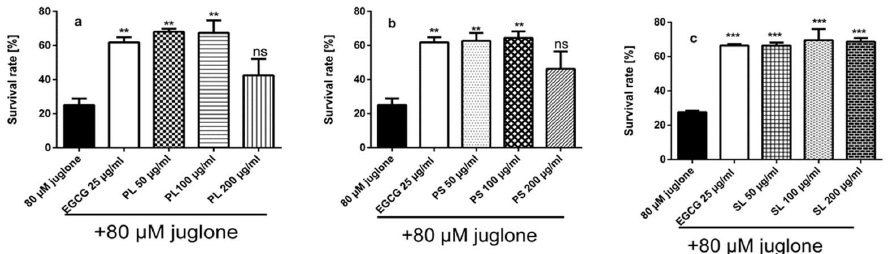
Figure 3. E ff ect of EGCG (epigallocatechin gallate) and extracts of PL ( P. alba leaf), PS ( P. alba shoots) and SL ( S. subserrata leaf) on the survival rate of C. elegans N2 (wt) against a lethal dose of juglone (80 µ M); ( a ) PL significantly enhanced the survival rate to 68.09% and 67.51% at doses of 50 and 100 µ g / mL, respectively; ( b ) The survival rates were significantly improved after pre-treatment of the worms with 50 and 100 µ g / mL of PS to 62.72% and 64.45%, respectively, while for the juglone treated control it was 25.08%; ( c ) SL significantly increased the survival rate to 66.36%, 69.52% and 68.65% at concentrations of 50, 100 and 200 µ g / mL, respectively. The results are represented as mean ± standard error of the mean (SEM) from three independent experiments. ns (not significant) p > 0.05, ** p < 0.01, *** p < 0.0001, compared to untreated control (negative control) by one-way analysis of variance (ANOVA) followed by Bonferroni (post-hoc).